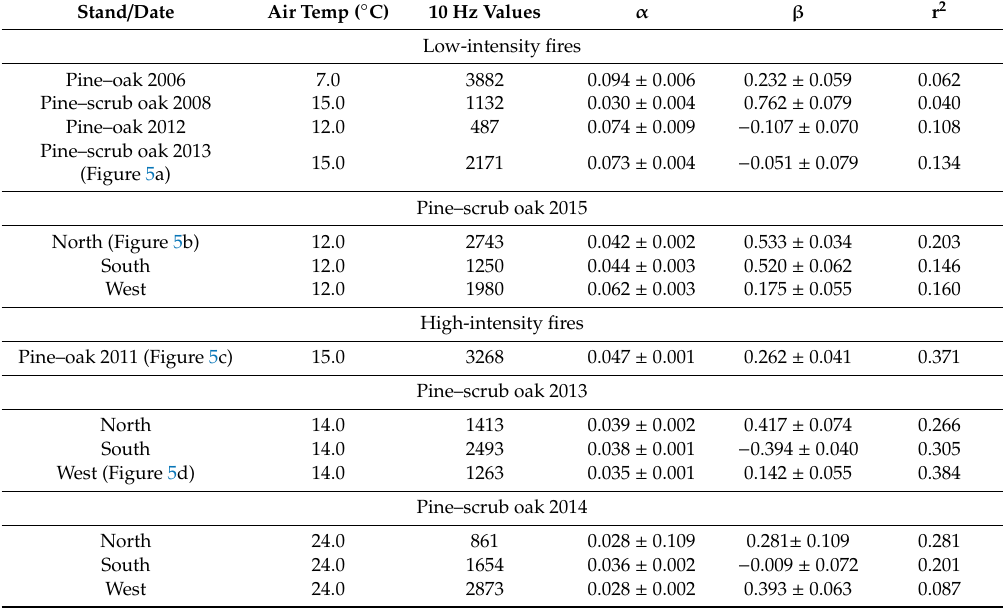
Table A3. Linear models of air temperature and vertical wind velocity measured at 10 Hz on burn area towers during the eight prescribed fires when air temperature was ≥ 5 ◦ C above ambient air temperature measured on control towers shown in Figure A1. Values are air temperature at ≥ 5 ◦ C above ambient air temperature, number of 10 Hz values ≥ 5 ◦ C above ambient air temperature when flame fronts were in the vicinity of each tower, and slopes, intercepts and Pearson’s correlation coe ffi cients for linear relationships. Data were fit to the equation y = α × (variable) + β .